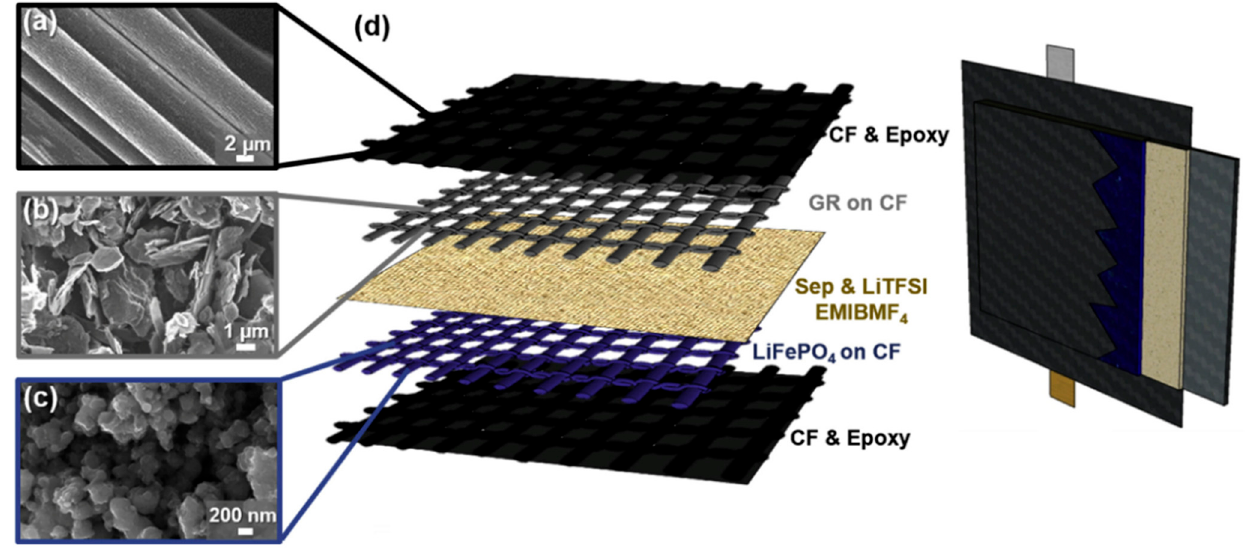
Figure 5. Example of a type ‐ III structural battery [20].